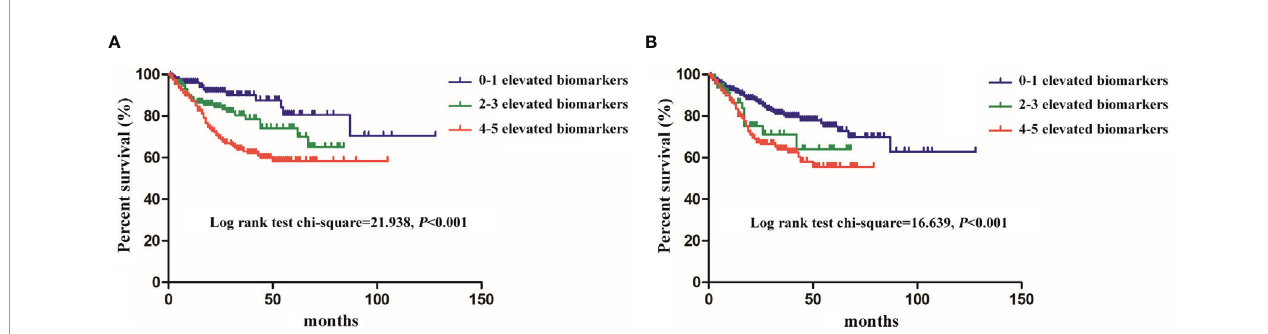
FIGURE 2 | The survival of the pseudomyxoma peritonei (PMP) patients with different numbers of elevated biomarkers (A) , serum biomarkers; (B) ,